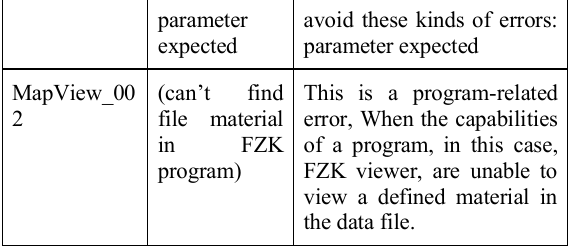
Table 3. Errors after initial conversion and how they were